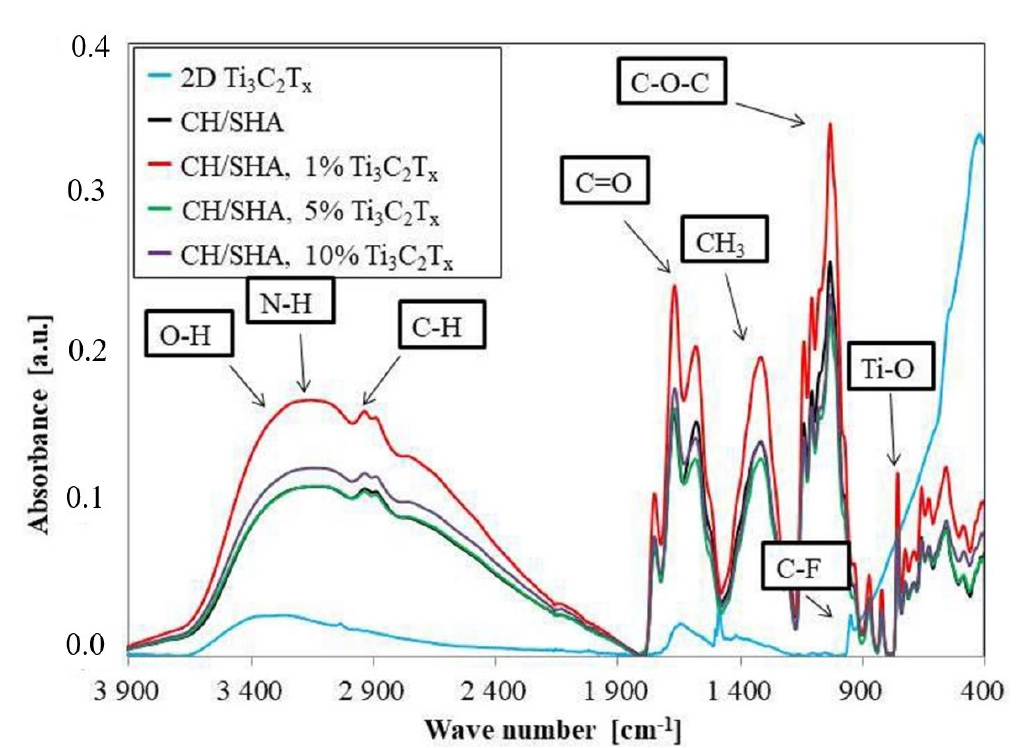
Figure 5. FTIR results for 2D Ti 3 C 2 T x MXene flakes, reference CH / SHA matrix nanocomposite as well as modified with 1, 5, and 10 wt.% of the